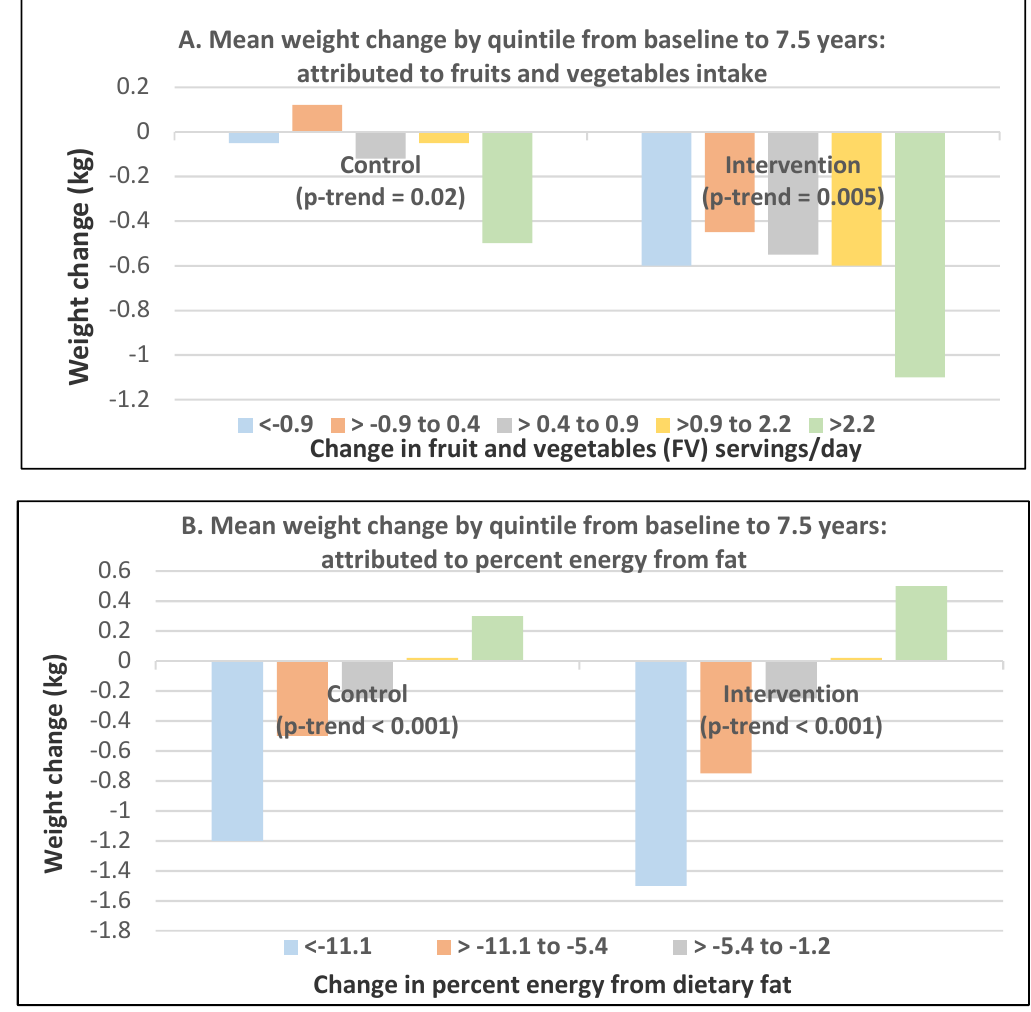
Figure 18. Lower dietary fat and increased fruit and vegetable (FV) (intervention) vs. general dietary guideline information (control) on weight change from baseline to 7.5 years of follow-up that was attributed to (A) increasing FV (servings/day) and (B) decreasing percent energy from fat in postmenopausal women [56].